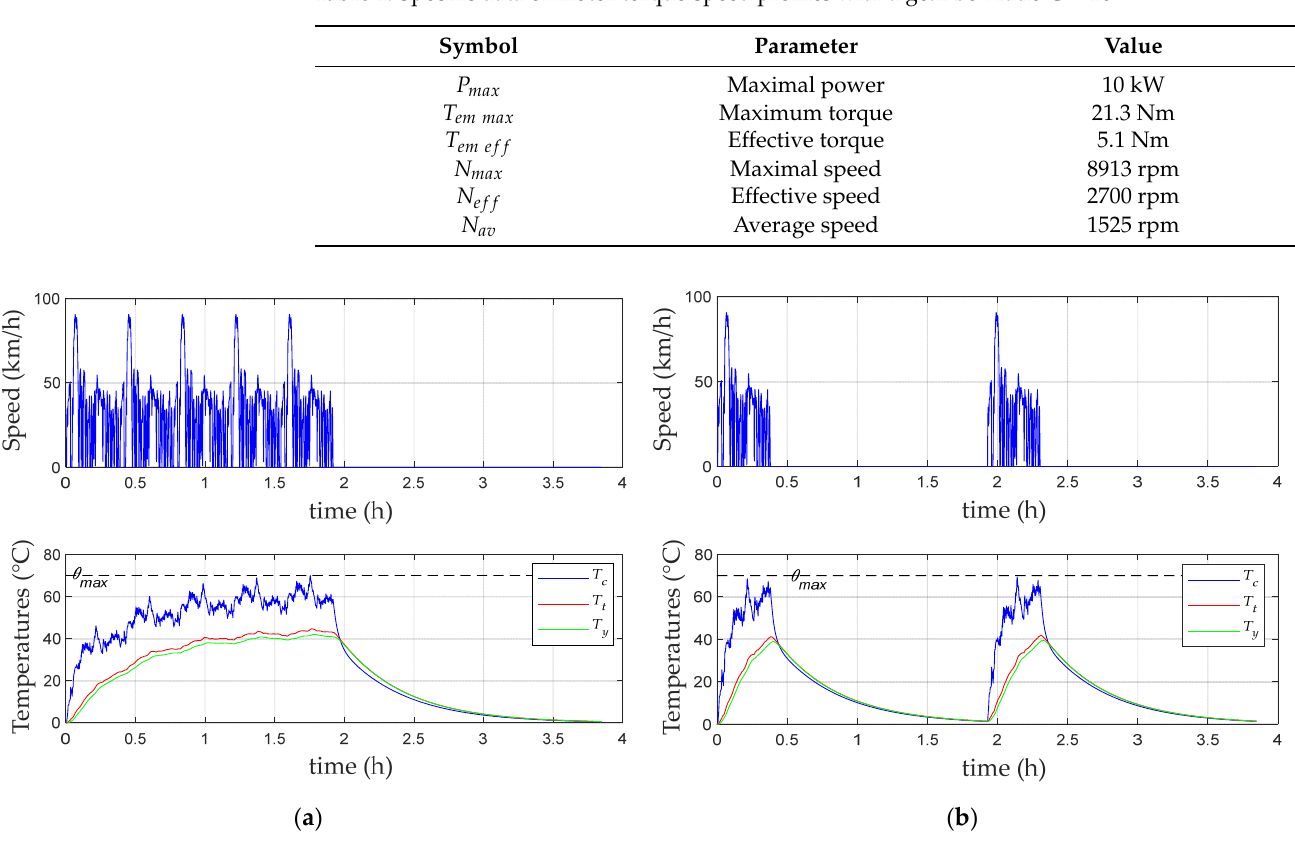
Figure 8. Working cycles and temperatures in continuous ( a ); and intermittent ( b ) duties.